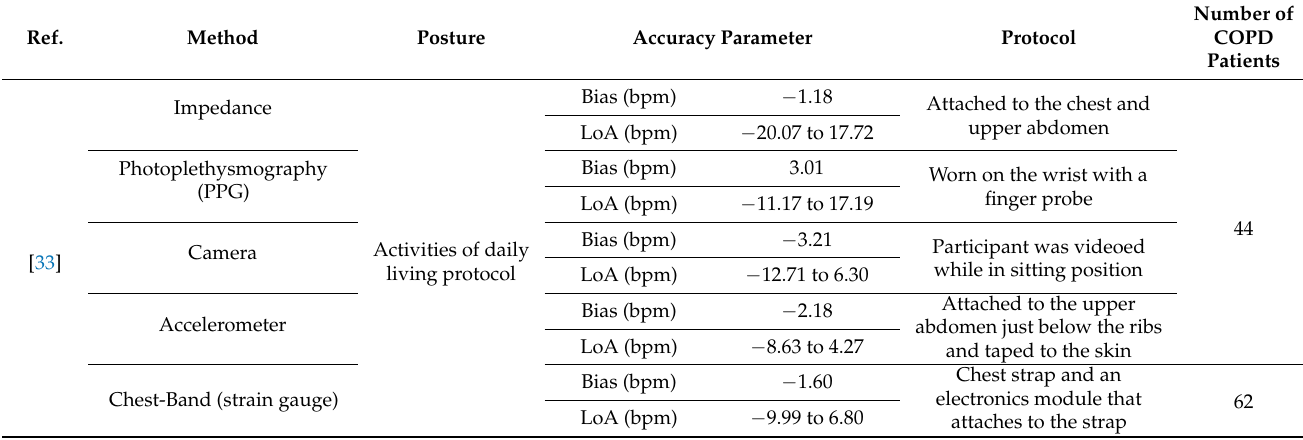
Table 1. Comparison between the accuracy and performance of the IJPT sensor and other sensors reported in the literature.